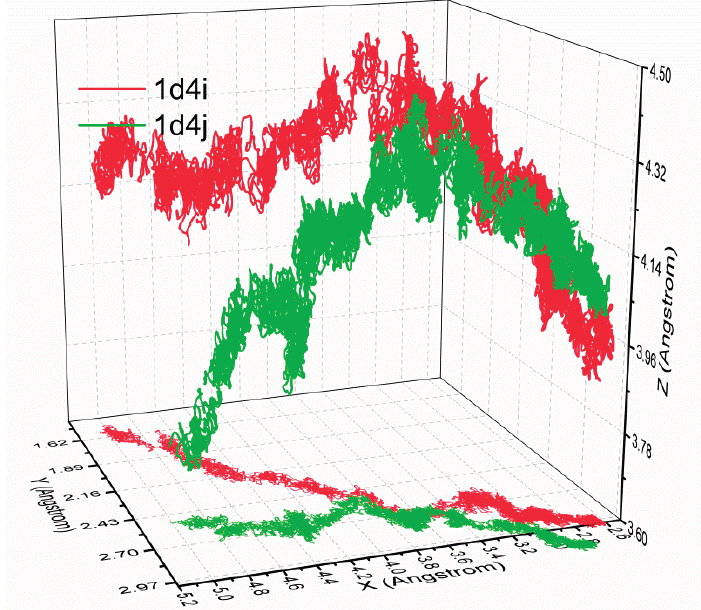
Figure 9. Ligand trajectories of 1d4i (shown in red line) and 1d4j (shown in green line) simulated with